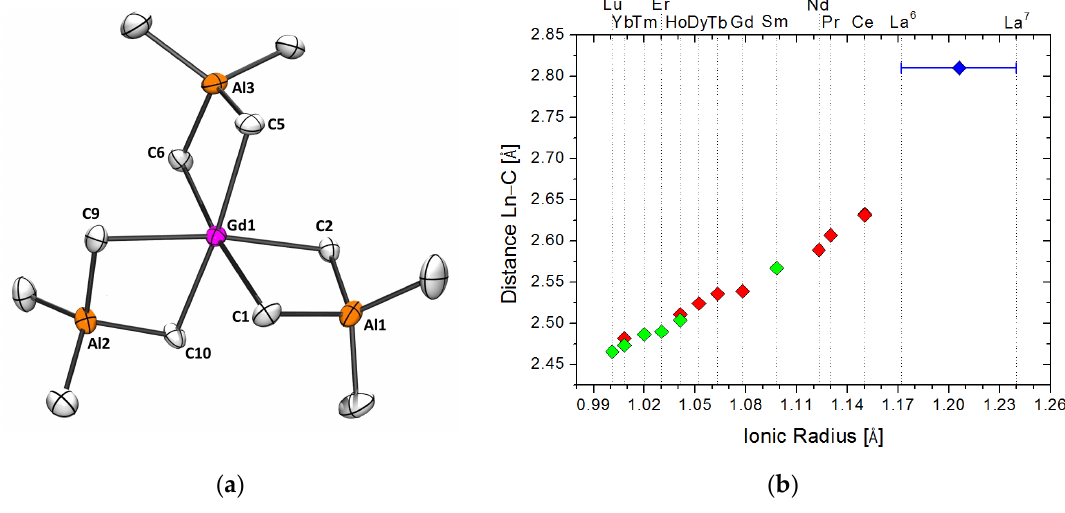
Figure 1. ( a ) ORTEP view of one of two individuals in the unit cell of 2 Gd . Atoms are represented by atomic displacement ellipsoids at the 50% level. Hydrogen atoms are omitted for clarity. Selected